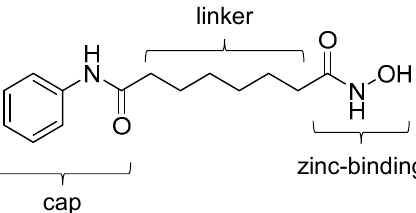
Figure 1. Chemical structure of SAHA. Three groups that constitute a typical HDAC inhibitor are indicated.